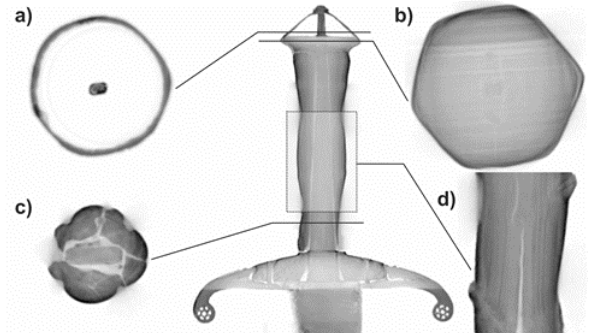
Figure 6. Virtual slices through the neutron CT data set. The high contrast for hydrogen allows for the inspection of various features: ( a ) Corrosion in the pommel, distinction between soft wood within the pommel and ( b ) hardwood in the grip. ( c , d ) Details on mounting of the grip ( c ) and the wood structure within the grip ( d ), revealing details on the decorative nails.